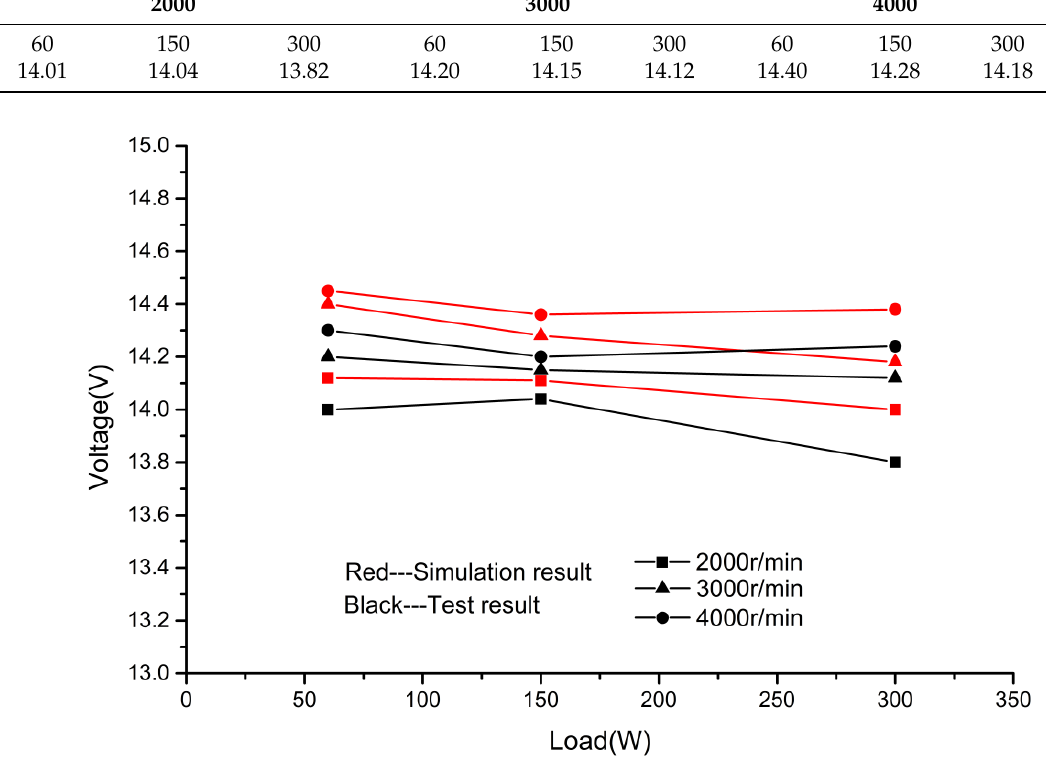
Table 2. Experiment results of output voltage.